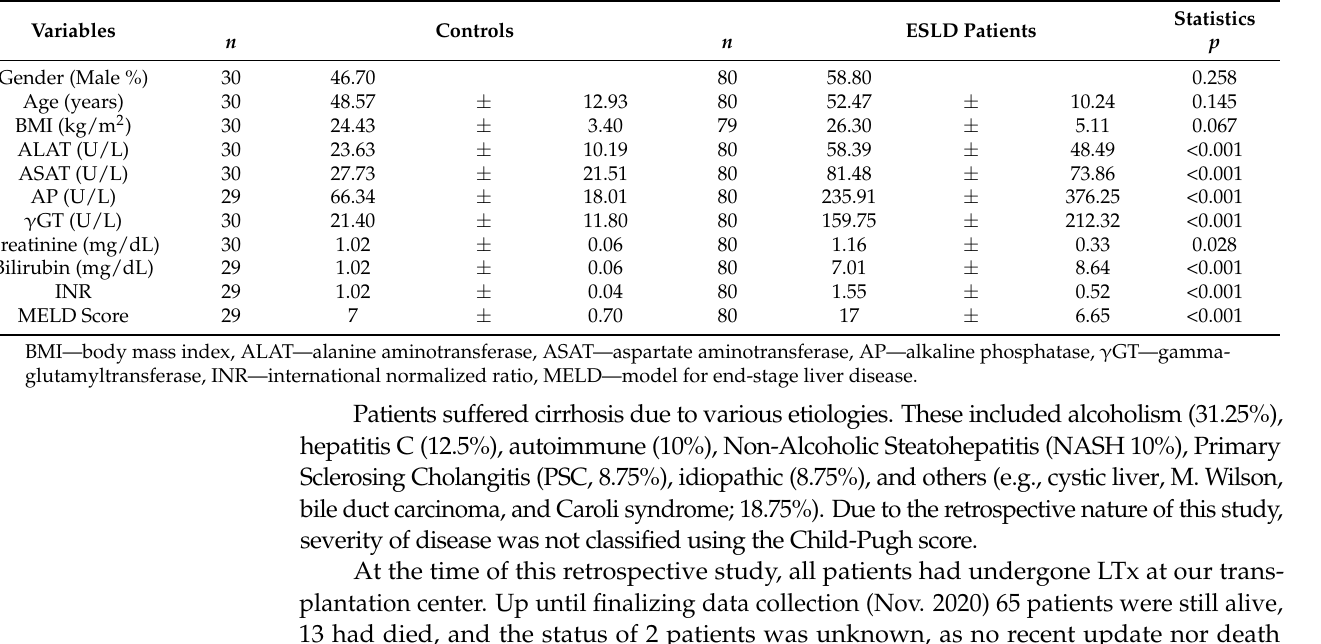
Table 1. Demographic and clinical data of healthy controls vs. end-stage liver disease (ESLD)